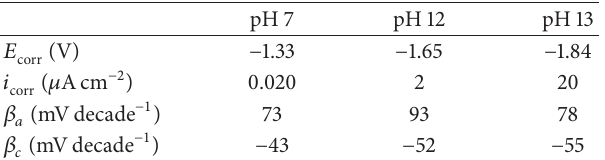
Table 1: Parameter values obtained from the polarization data